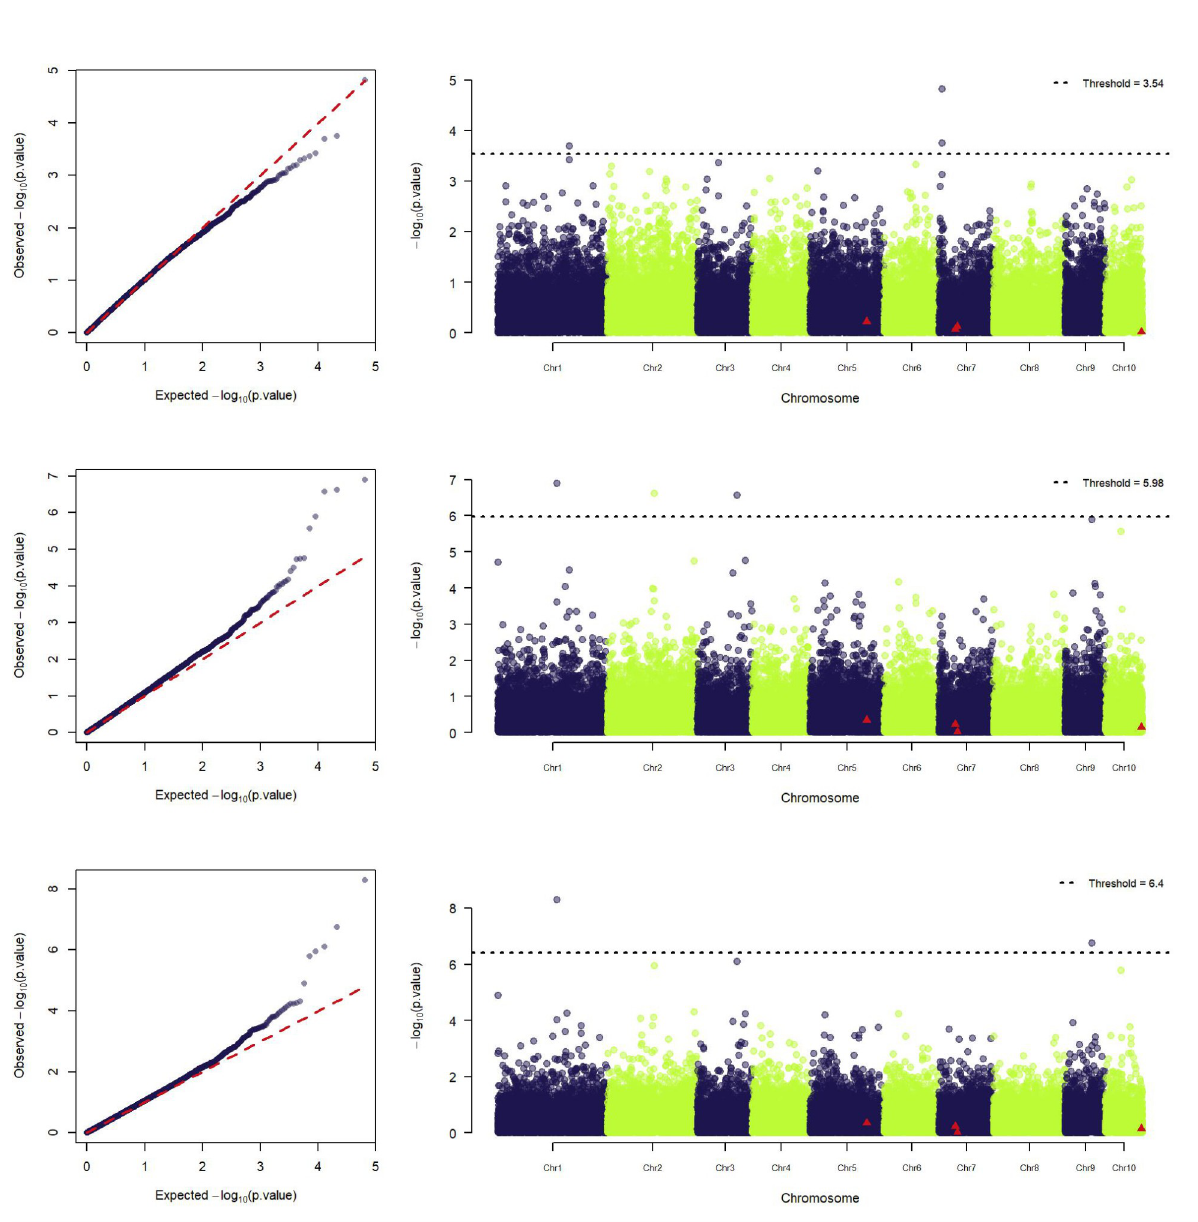
Fig 2. Manhattan and QQ-plots of GWAS for low nitrogen tolerance index (LNTI) of 904 maize single-crosses using 34,571 markers. Plots represent additive effect with model S the inbred lines by Morosini et al. [18] are represented by red triangles in the Manhattan plot.